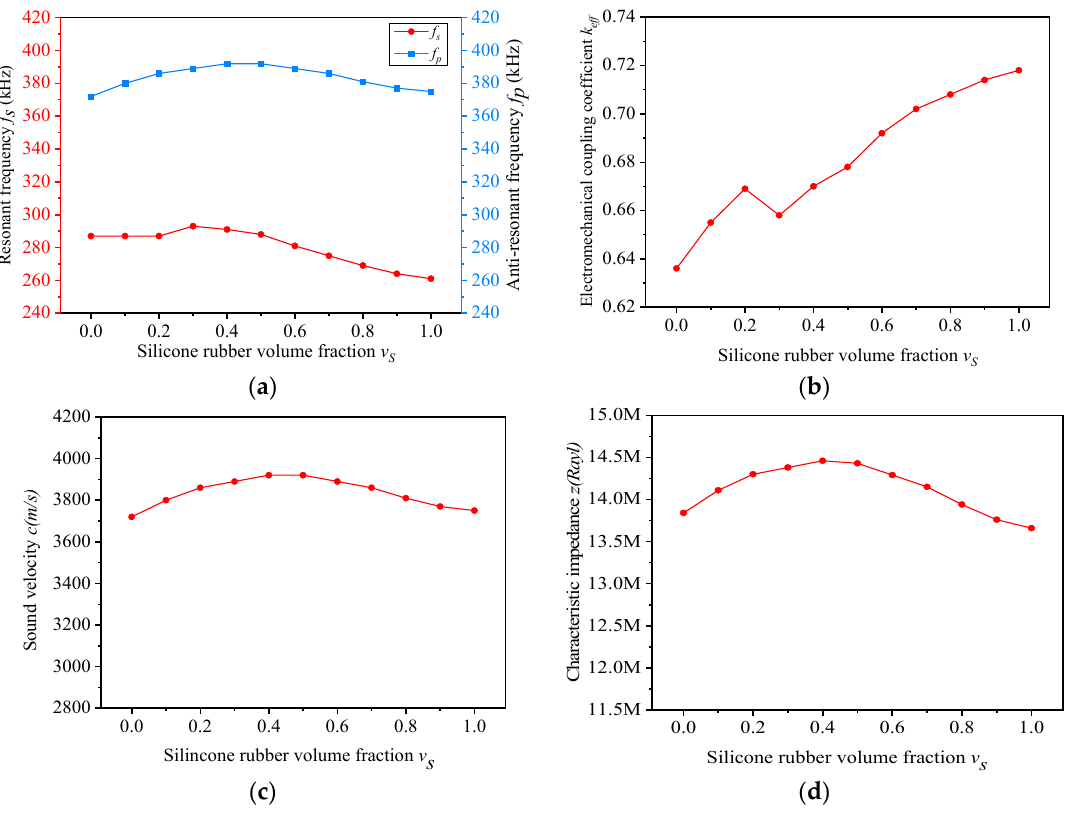
Figure 4. ( a – d ) Simulation performances of the composites with different v s (v c = 0.4).